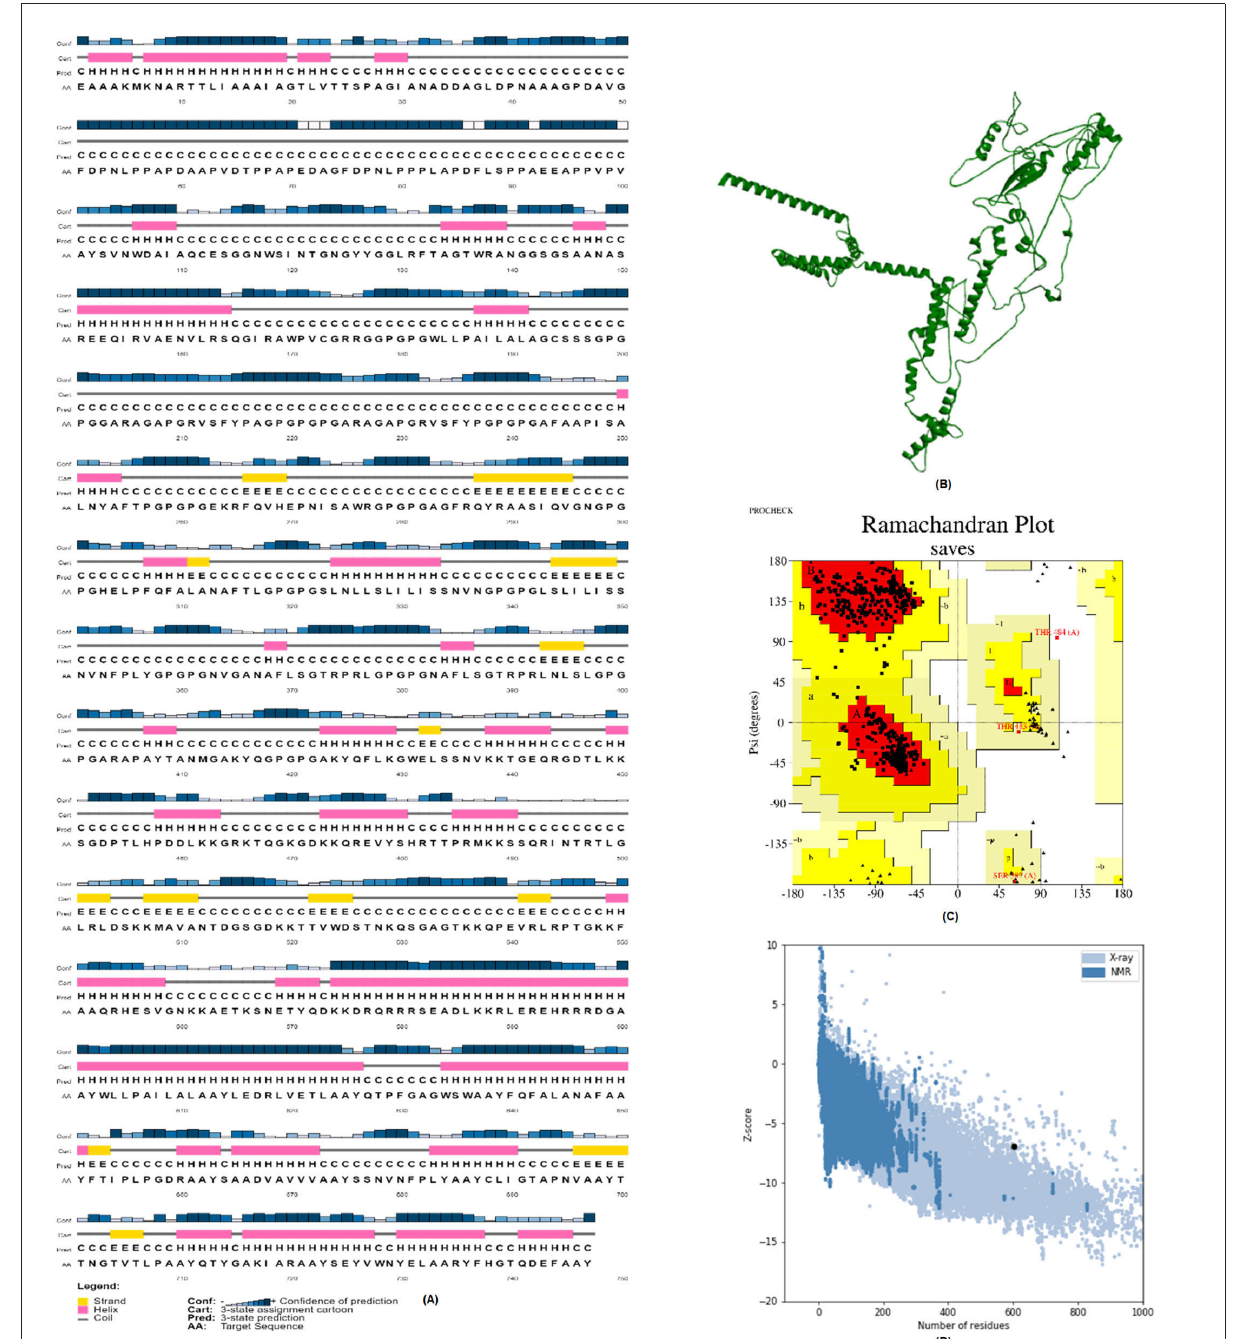
FIGURE7 Structure prediction and validation of vaccine construct. (A) PSIPRED server results of secondary structure of vaccine. (B) The Robetta server used to predict the Tertiary structure of vaccine. (C) The PROCHECK server used to analyze the Ramachandran Plot. (D) Z -score analyzed by the Pro-SA web server.